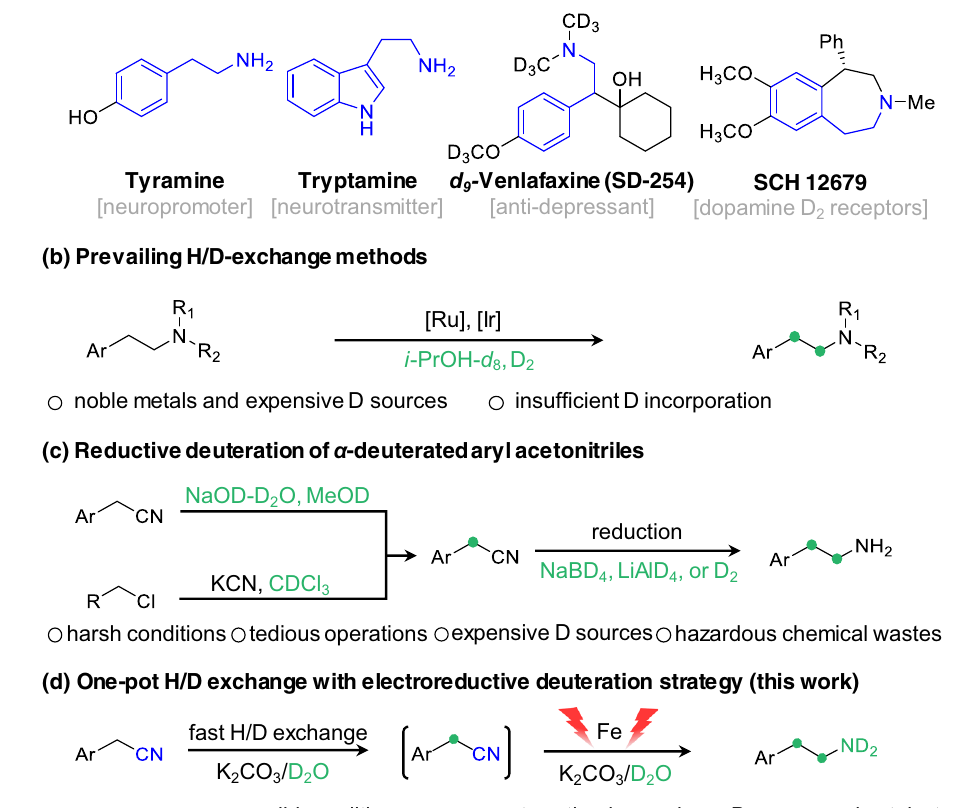
Fig. 1 | Schematic comparison of synthesis of deuterated aryl ethylamines. a Representativeexamplesofarylethylaminerelateddrugs.Typicalmethods b and